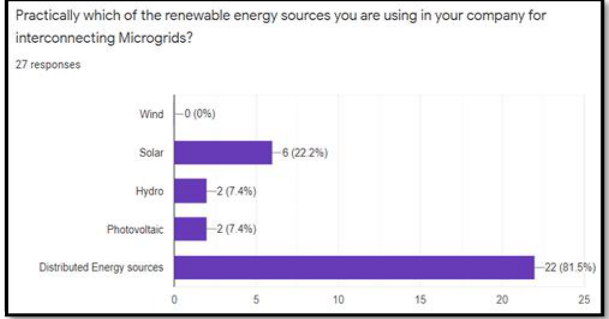
Figure 7. Responses stating the type of renewable energy sources used in different companies